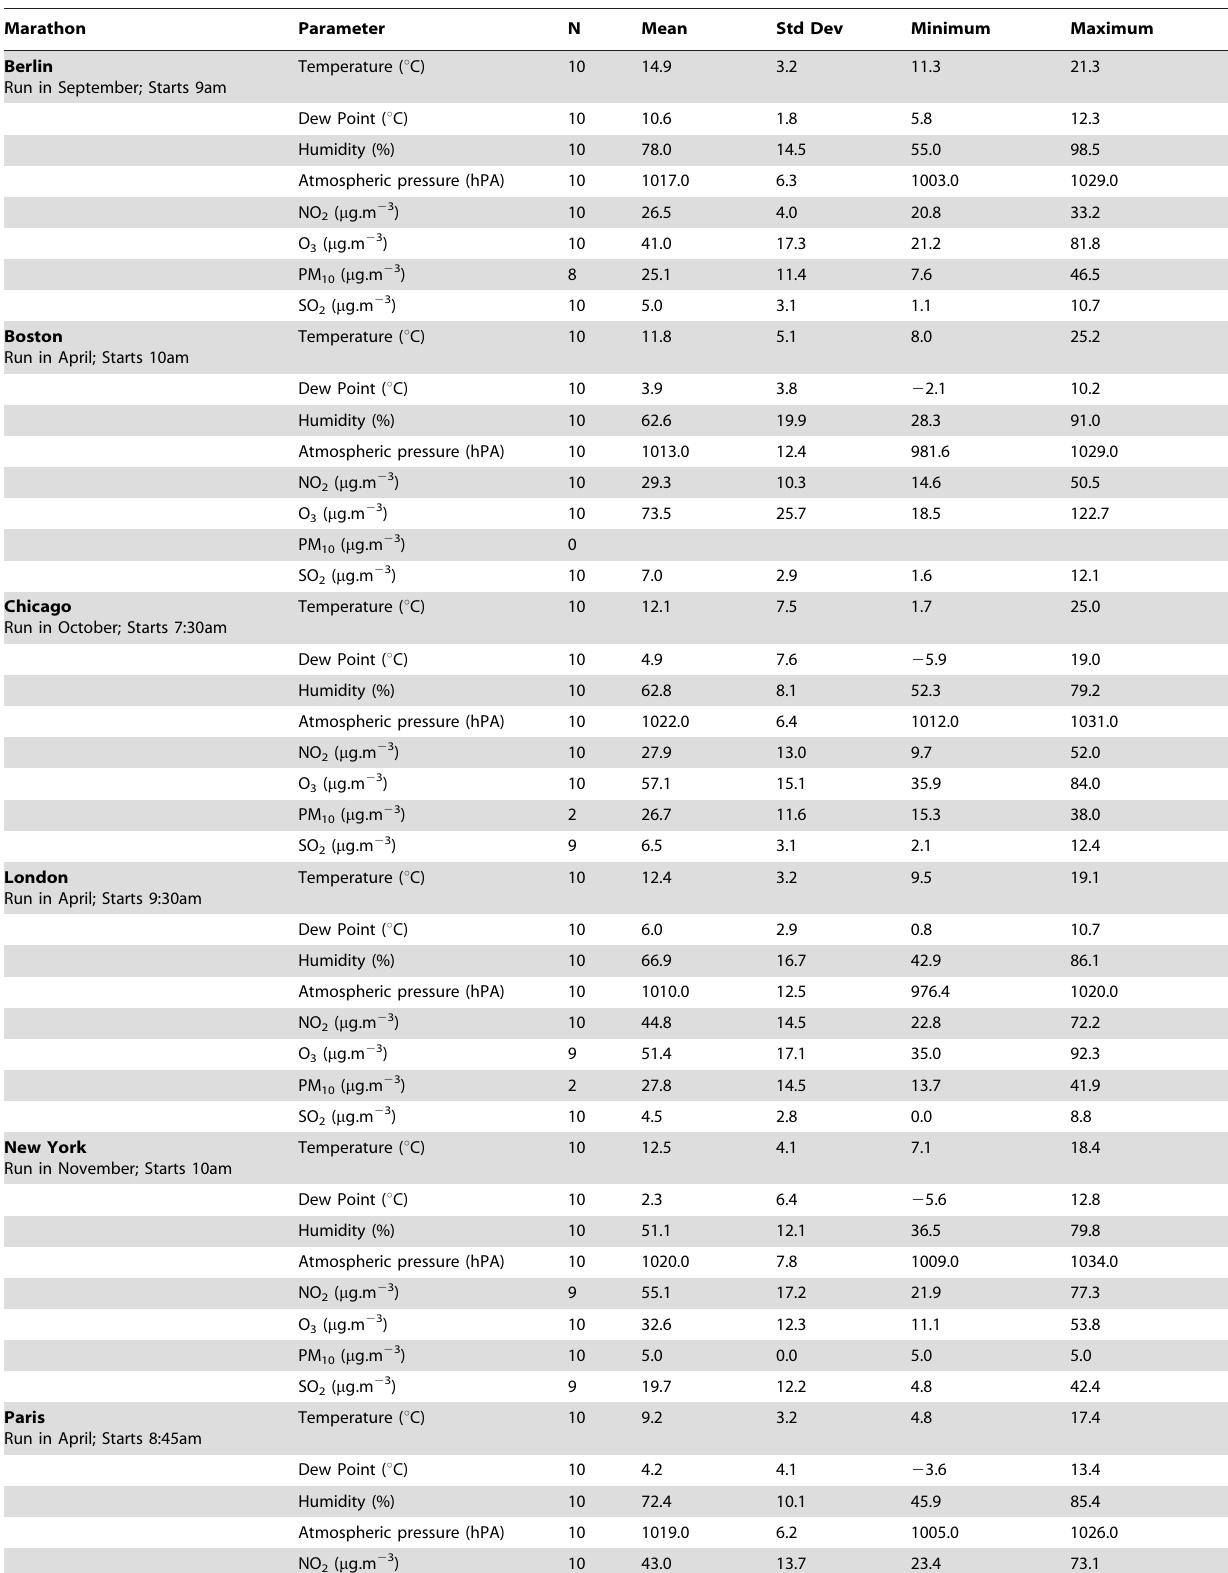
Table 1. Average and range values of all weather and pollution parameters for the six marathons.